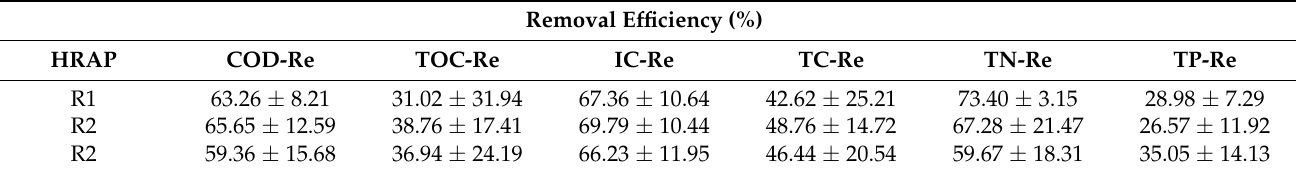
Table 3. Removal efficiency (%) of COD, TOC, IC, TC, TN, and TP in reactors R1, R2, and